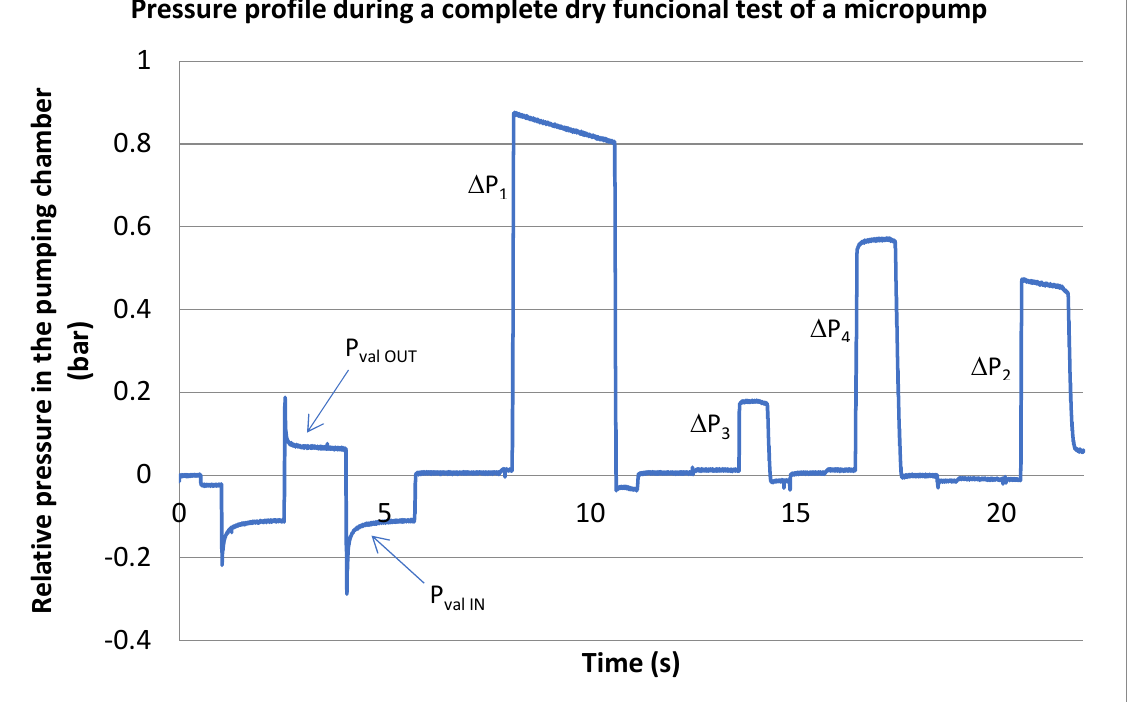
Figure 13. Experimental pressure profile during the extended dry test of a functional micropump. The different pressure gradients refer to the compression tests described in the previous sections. P val IN and P val OUT are the inlet and outlet valve pretensions,